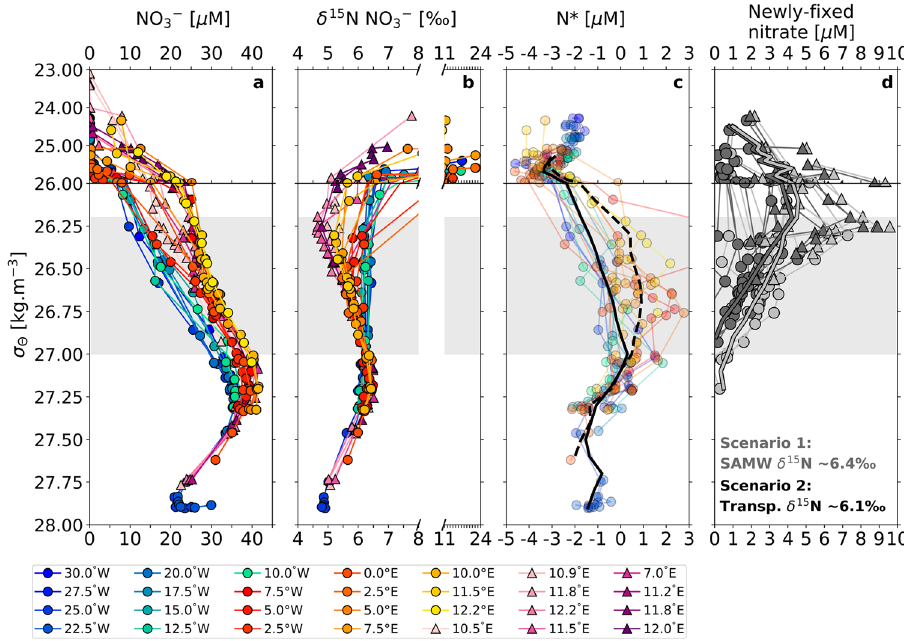
Fig. 3 Characteristics of tropical South Atlantic nitrate. Density pro fi les of a nitrate concentrations in µ M; b nitrate δ 15 N in ‰ versus N 2 in air; c N* ( = [NO 3 − ] – 15.5 × [PO 4 3 − ]; SI.1) in µ M; and d the depth-speci fi c concentration of newly- fi xed nitrate in μ M in the Angola Gyre. In a – c , warm (cool) coloured pro fi les represent stations from the Angola Gyre (tropical western basin). Round markers show data from the CoFeMUG transect while triangle markers represent data from the MET131 transect. The legend provides station longitude. The grey shading on a – d indicates the density range of TW. In c, the dashed (solid) black line indicates the mean gridded N* for the Angola Gyre (western basin) stations; only CoFeMUG data are shown here because of the higher depth resolution of this sample set. d shows the concentration of newly- fi xed nitrate in the Angola Gyre, computed by multiplying the depth-speci fi c fraction of newly fi xed nitrate ( f depth_speci fi c ; equation S3b) by the corresponding nitrate concentration at each depth. To calculate f depth_speci fi c , a nitrate δ 18 O-based correction is applied to the δ 15 N data to remove the phytoplankton nitrate assimilation signal from Tropical Surface Water (SI.7). Light grey data show results from scenario 1 while dark grey data show scenario 2 (see text for details). The mean of each scenario is indicated by the bold line of corresponding